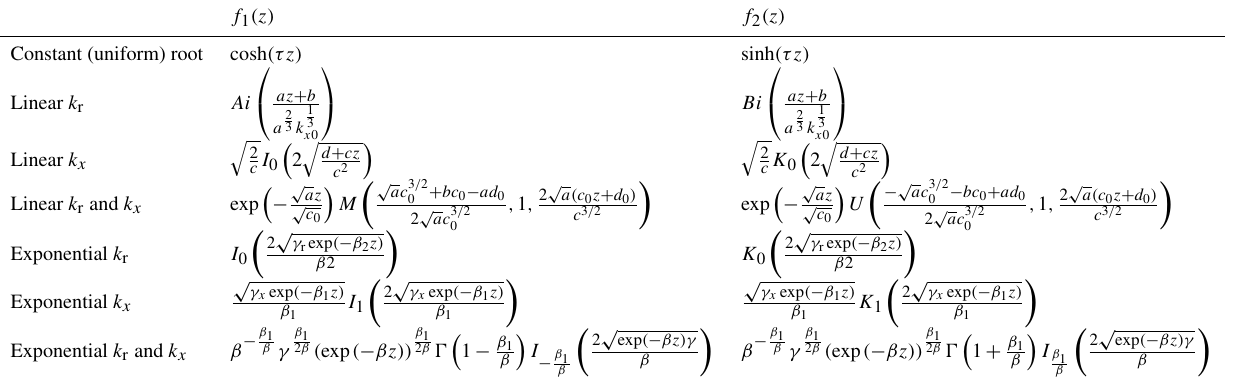
Table 2. Linearly independent functions f 1 and f 2 solutions of Eq. (4) according to the functions describing local root hydraulic properties shown in Table 1. Parameters are described in Table